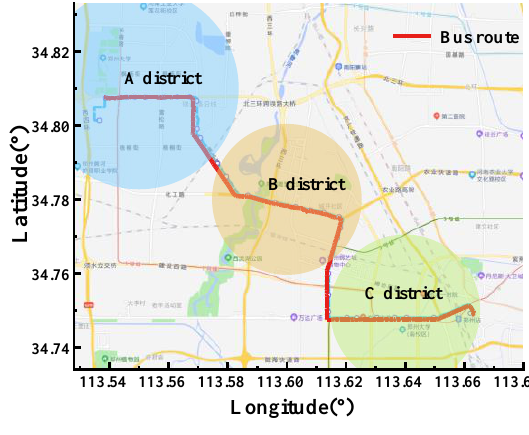
Figure 10. Bus route map.